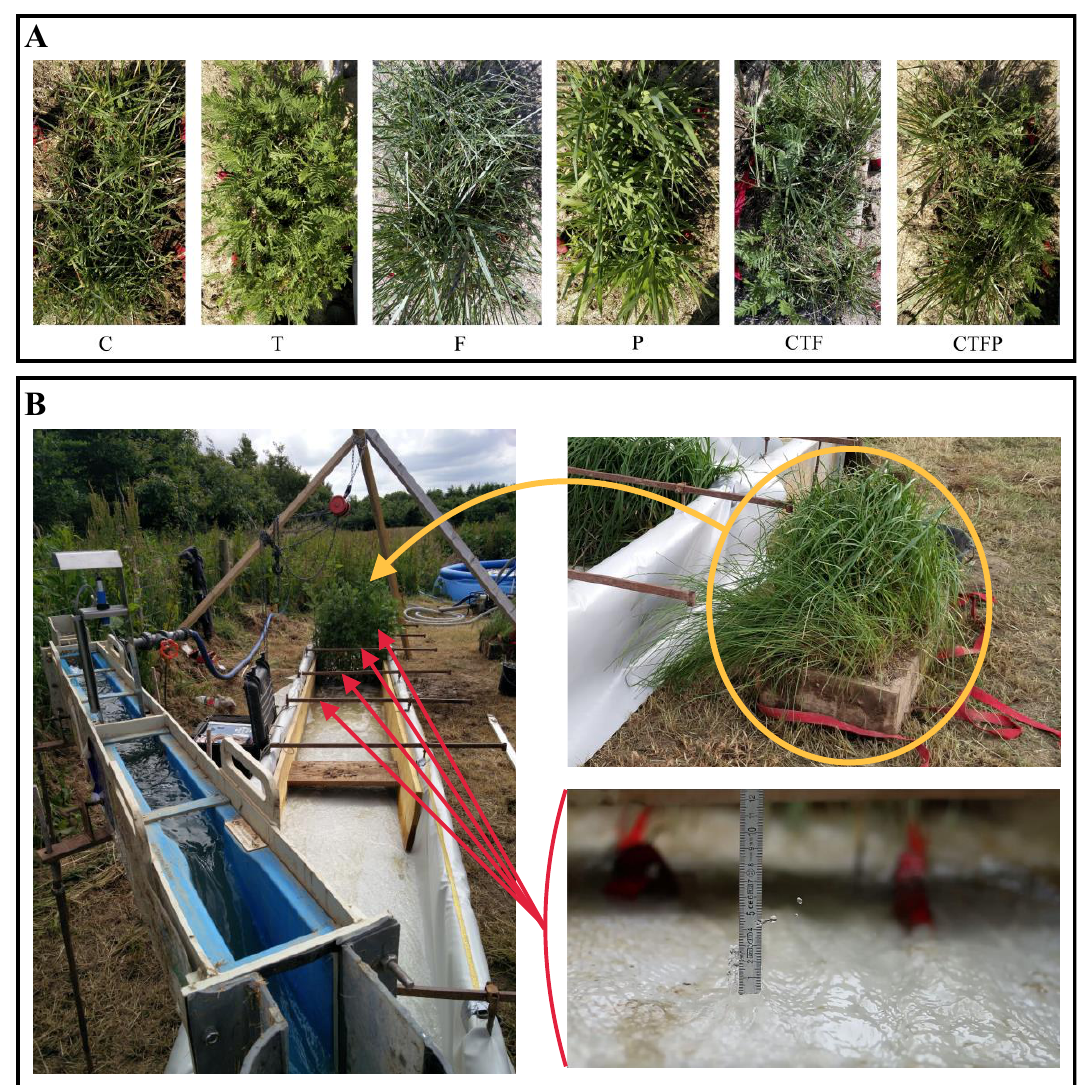
Figure 1. Experimental design: ( A ) Three levels of plant functional diversity with four monospecific and two multi-specific conditions; and ( B ) runoff simulator set-up used for the experiments and water level measurement. The photos of the plots were taken 1.5 month prior to the experiments. C – Carex flacca , T – Tanacetum vulgare , F – Festuca arundinacea and P – Phalaris arundinacea ; CTF – Carex flacca + Tanacetum vulgare + Festuca arundinacea ; CTFP – Carex flacca + Tanacetum vulgare + Festuca arundinacea + Phalaris arundinacea .